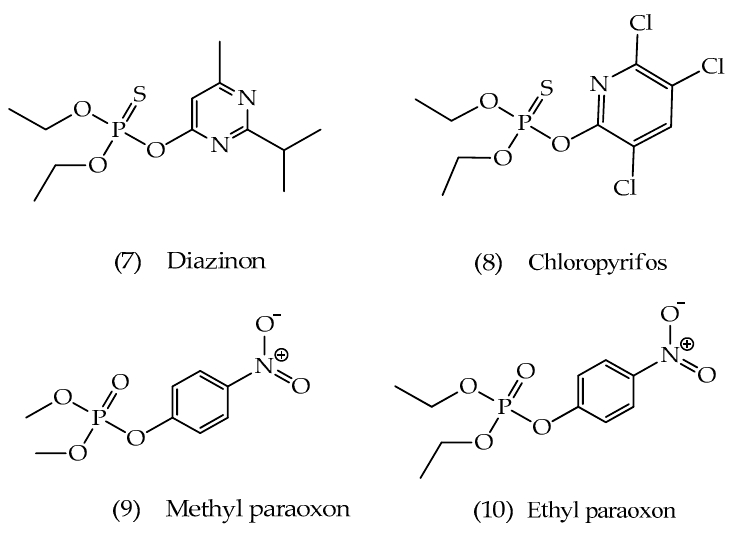
Figure 7. Chemical structures of some important pesticides.